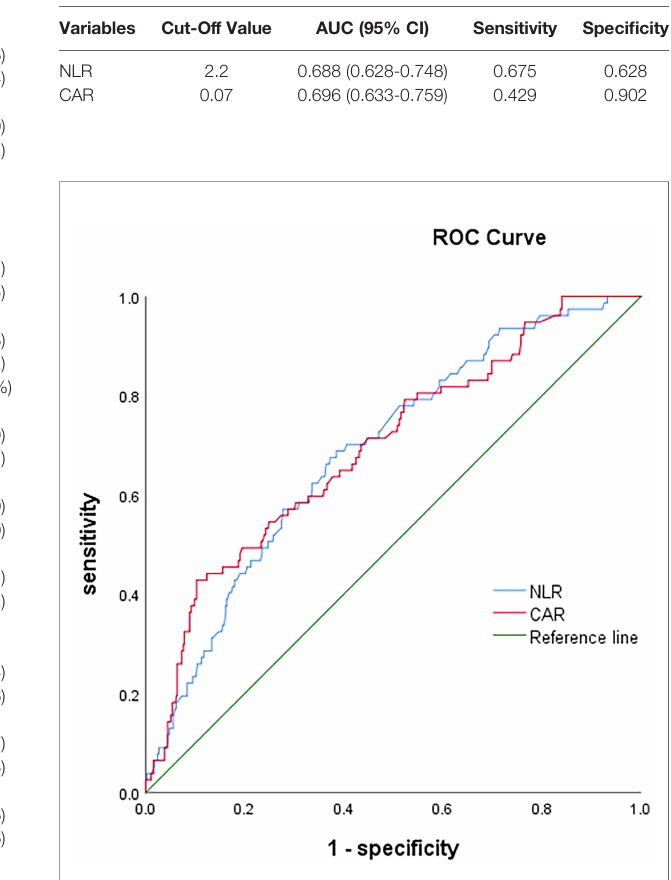
TABLE 2 | Receiver Operating Characteristics (ROC) Analyses of NLR and CAR in luminal breast cancers with HER2-negativity.